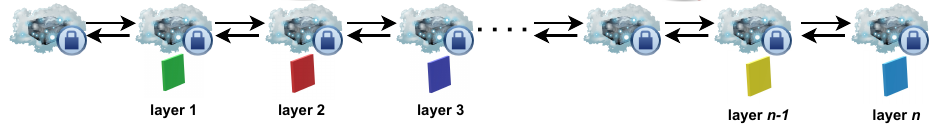
Figure 1. MixNN design